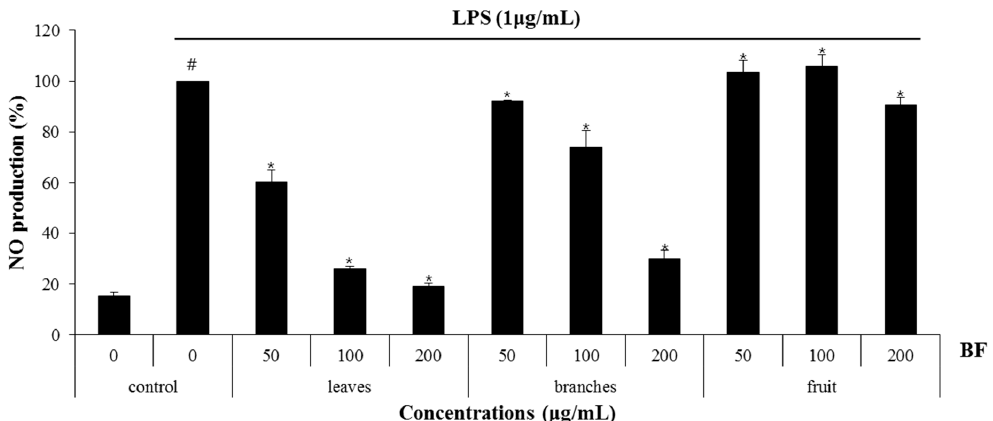
Figure 1. The effect of leaves, branches, and fruit of Berchemia floribunda (BF) on nitric oxide (NO) production in lipopolysaccharides (LPS)-stimulated RAW264.7 cells. RAW264.7 cells were pretreated with leaves, branches and fruits of BF for 6 h and then co-treated with LPS (1 µ g/mL) for 18 h. NO production was measured by Griess assay. # p < 0.05 compared to the cells without the treatment, and * p < 0.05 compared to the cells treated with LPS alone.